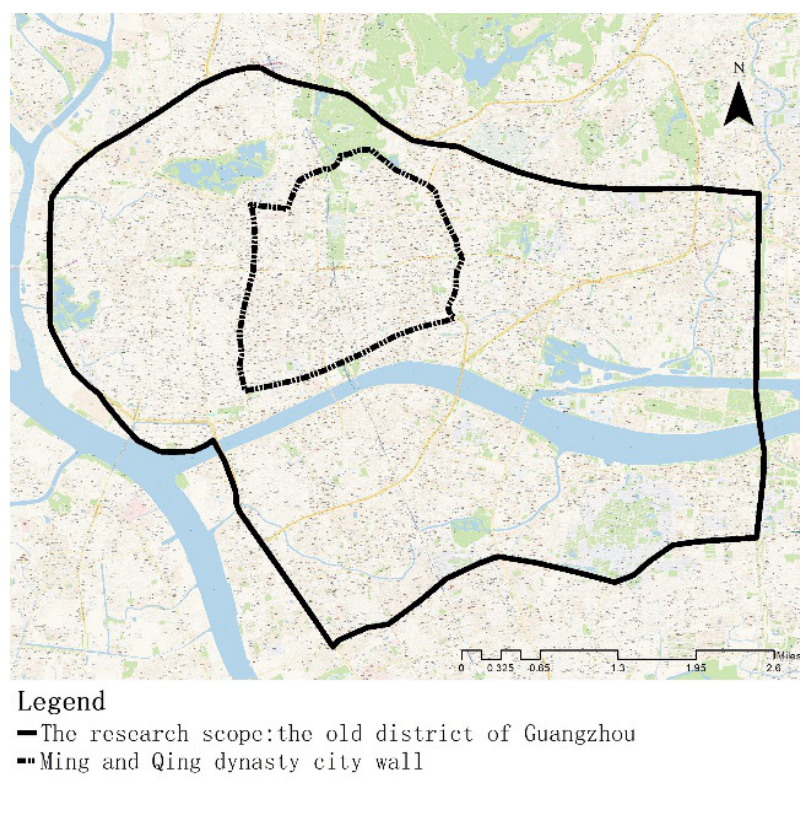
Fig. 1 Scope of the old district of